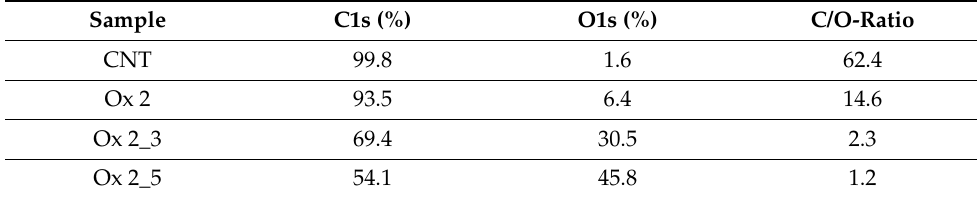
Table 4. XPS results referred to the amounts of carbon and oxygen.